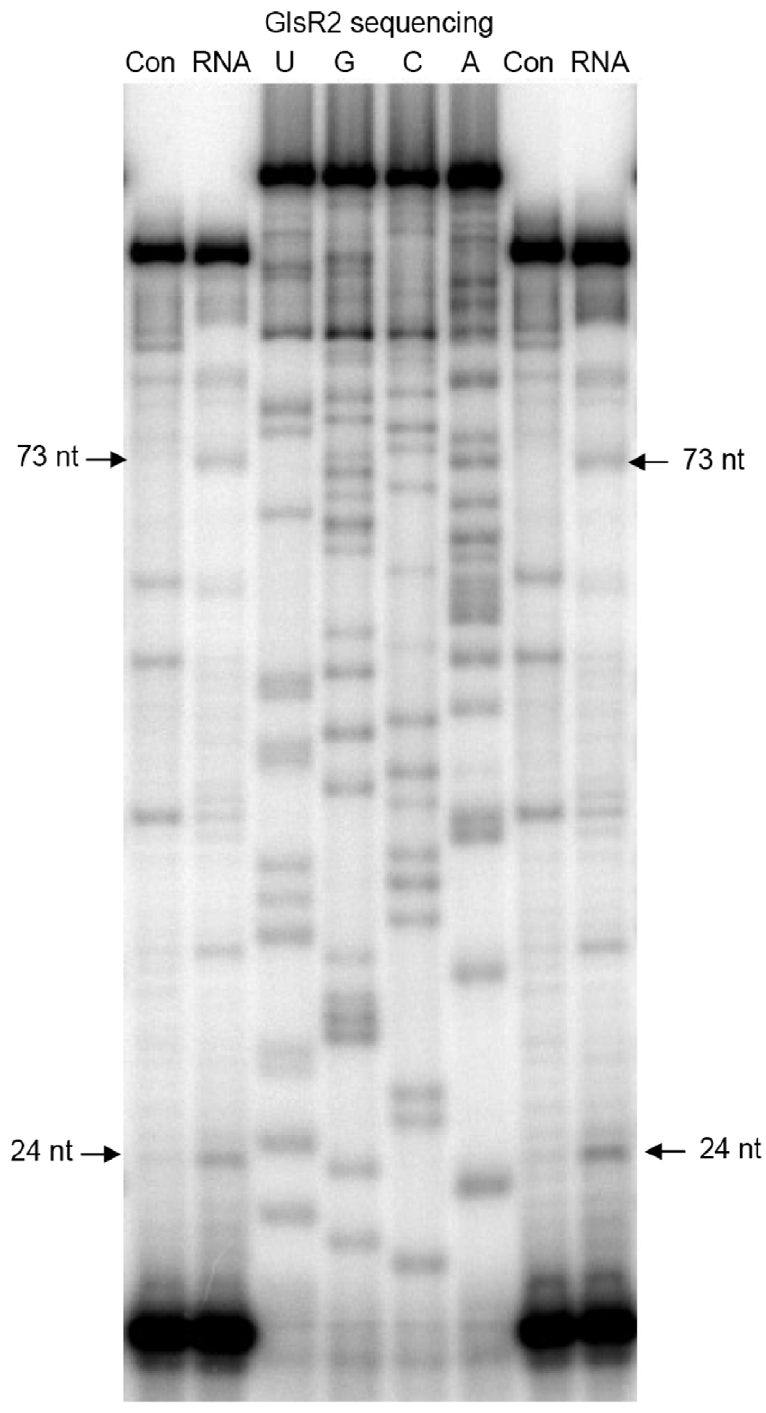
Figure 2. Determination the 5 9 end of GlsR2-derived small RNA by primer extension. A 17 nt end-labeled primer complementary to the 3 9 end of GlsR2 were used in the primer extension reactions. In vitro transcribed GlsR2 (0.75 ng) was used as a control template (Con) to show the secondary structure stops. Size-fractioned small RNA ( , 200 nts, 4 m g) was used as another template (RNA) to identify the mature miR5 and its potential intermediary precursor. GlsR2 sequencing reactions, using the same primer, were run along with the primer extension to determine the sequences of the products.